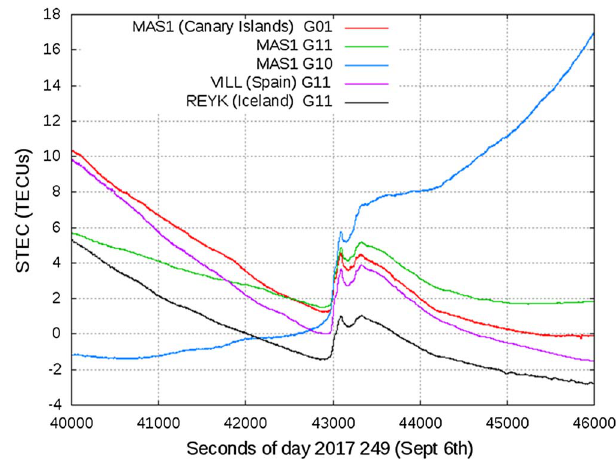
Fig. 1. STEC sudden increase at three different receivers for three